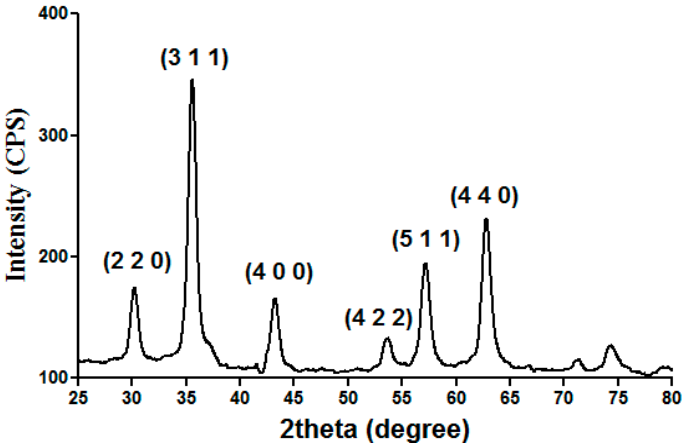
Figure 1. X ray diffraction (XRD) pattern of Fe 3 O 4